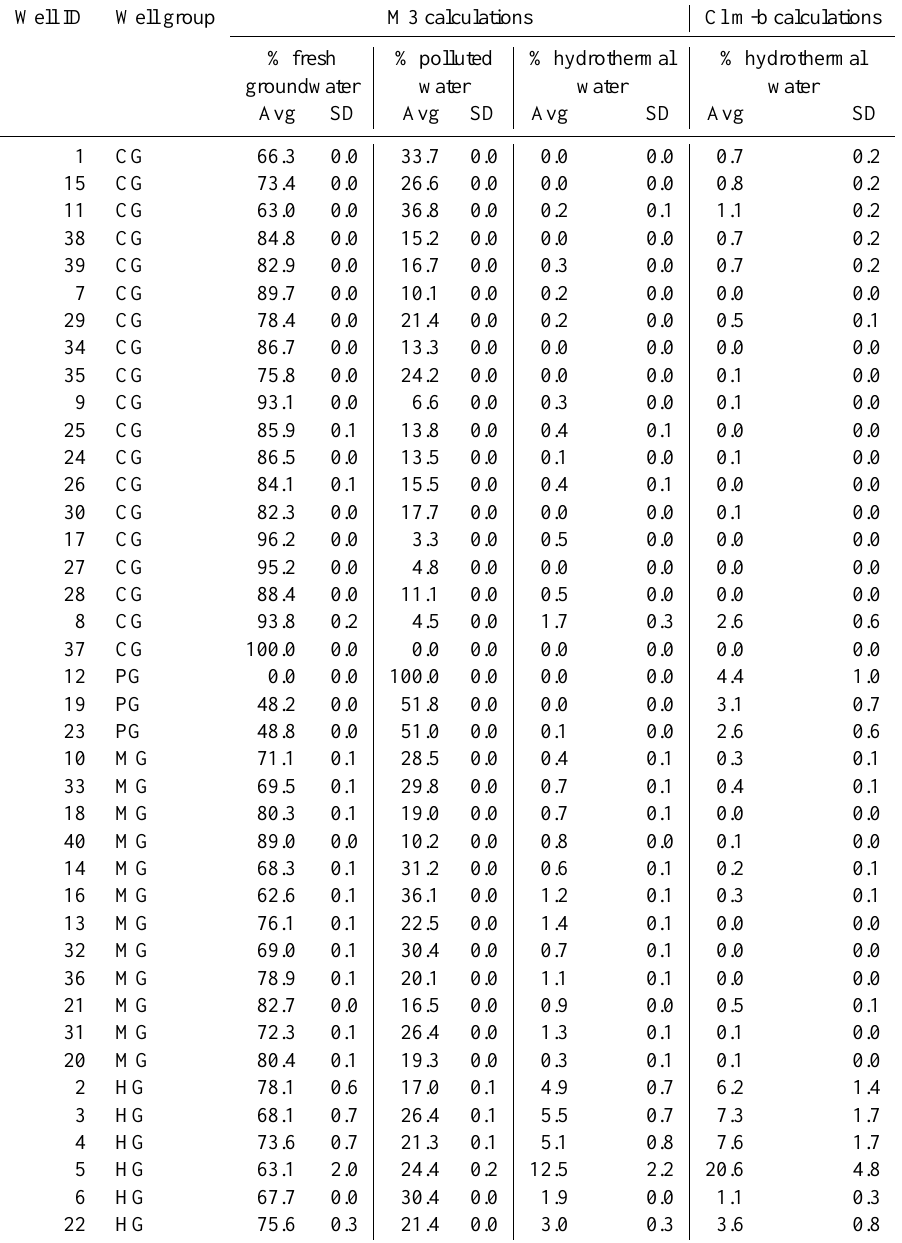
Table 4. Mixing proportions from the multivariate mixing and mass balance model, M3, using the following reference waters: deep wells PP1, PP2 and PP3 as a reference for hydrothermal fluids; no. AT12 as a reference for polluted water; and no. AT37 as a reference for fresh groundwater and hydrothermal mixing proportions based on Cl mass balance (m-b) calculations. Note: Avg represents the average obtained from calculation using the three different hydrothermal reference waters; SD represents standard